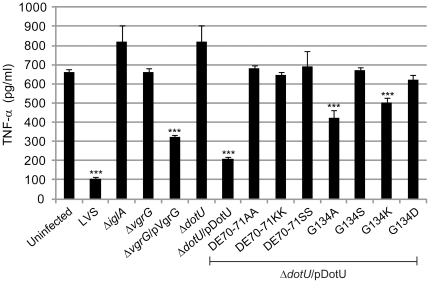
TNF-α secretion of F. tularensis infected J774 cells.J774 cells left uninfected (-) or infected with F. tularensis at an MOI of 500 for 2 h, were washed and subsequently incubated in the presence of E. coli-derived LPS (50 ng/ml) for an additional 2 h. The average TNF-α secretion in pg/ml and standard errors from two experiments, in which quintuplicate samples (n = 5) were used is shown. In the absence of LPS, the cytokine levels were below the limit of detection for the assay (<15 pg/ml) (data not shown). A Student's 2-sided t-test was used to determine whether the TNF-α secretion induced by the various F. tularensis strains was significantly different from that of the uninfected control (***, P<0.001).